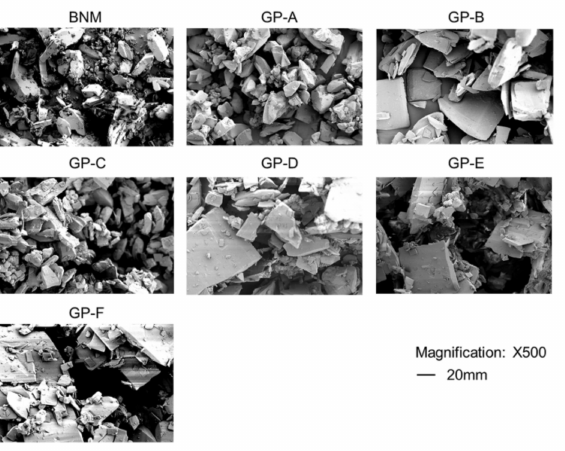
Figure 1. Images of particles of brand-name meropenem (BNM) and six generic products (GP-A to -F) using scanning electron microscopy. Magnification: 500 ×